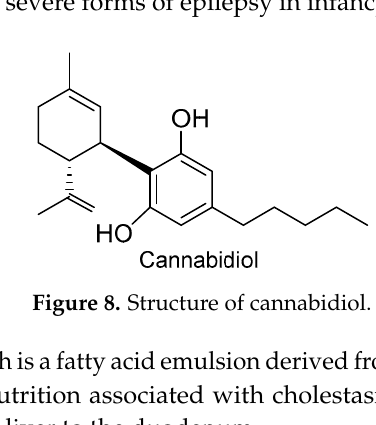
Figure 7. Structure of Annovera TM , a combined steroid derived drug.